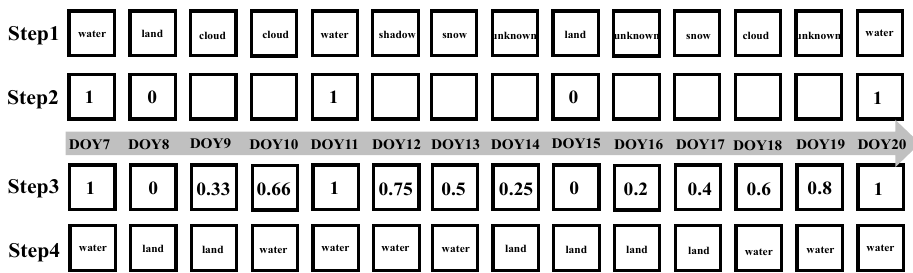
Figure 4. An example of the temporal interpolation of daily water estimates for a pixel.